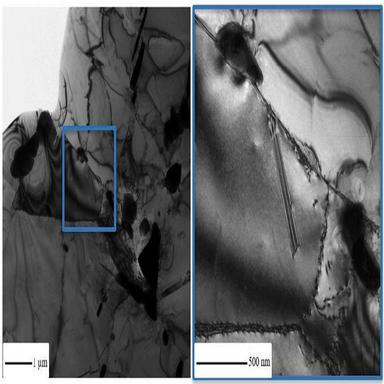
BF TEM of Alloy 709 after 900 ◦C and 50 MPa Creep Test showing Stacking Fault.